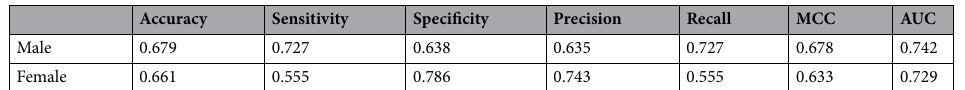
Table 4. Evaluation of Neural Network Algorithm in Parkinson’s disease prediction stratified by Sex. MCC Matthews correlation coefficient, AUC area under the receiver operating characteristic curve.